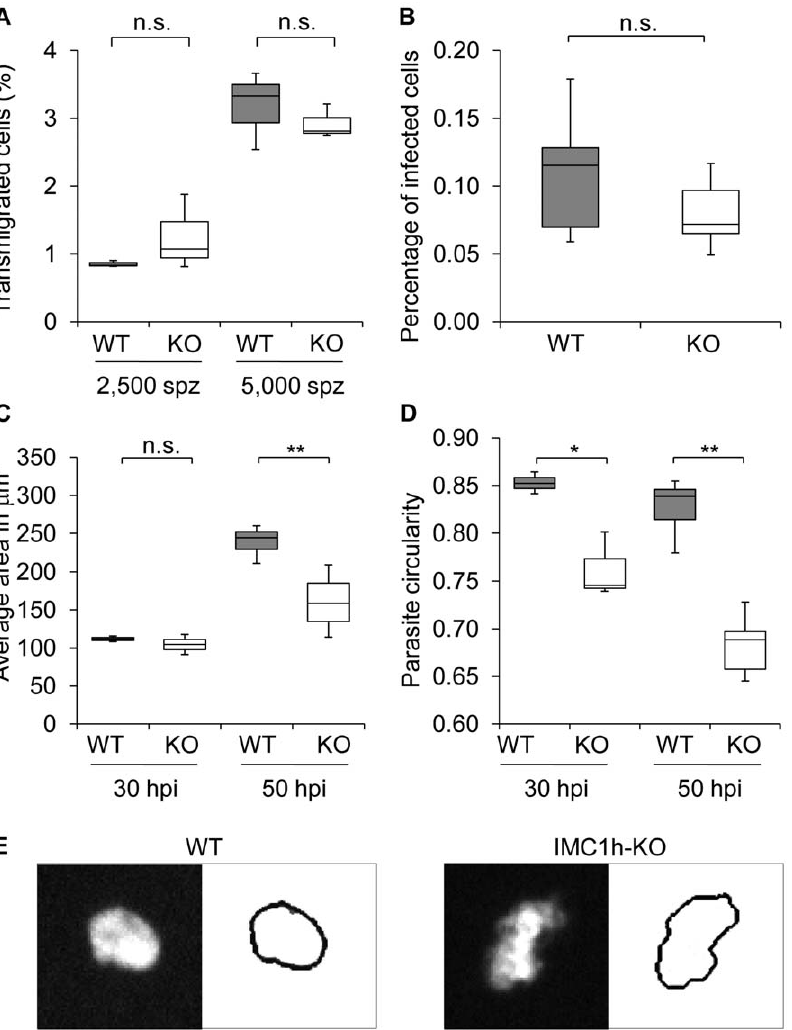
Figure 6. Invitro transmigration ability, infectivity and intracellular development of IMC1h-KO parasites. A. Hepa 1–6 cells were incubated with WT or IMC1h-KO sporozoites (spz) in the presence of rhodamine-dextran for two hours. The results are given as the percentage of cells filled with rhodamine-dextran (WT 2,500 spz, n=3, 257 cells; IMC1h-KO 2,500 spz, n=3, 234 cells; WT 5,000 spz, n=3, 561 cells; IMC1h-KO 5,000 spz, n=3, 403 cells). B. Hepa 1–6 cells invasion rate of WT and IMC1h-KO parasites at 50 hpi. Results are given as percentage of infected cells (WT, n=6, 341 cells; IMC1h-KO, n=6, 186 cells). C. Parasite area of WT and IMC1h-KO parasites in Hepa 1–6 cells at 30 and 50 hpi (WT 30 hpi n=3, 181 cells; IMC1h-KO 30 hpi, n=3, 99 cells; WT 50 hpi, n=6, 341 cells; IMC1h-KO 50 hpi, n=6, 186 cells). D. Average circularity of WT and IMC1h-KO parasites in Hepa 1–6 cells at 50 hpi. Mutant parasites displayed a lower circularity than WT parasites indicating a more irregular and elongated shape (WT 30 hpi n=3, 181 cells; IMC1h-KO 30 hpi, n=3, 99 cells; WT 50 hpi, n=6, 341 cells; IMC1h-KO 50 hpi, n=6, 186 cells). E. Cropped images acquired with Cellomics ArrayScan VTI HCS Reader show WT (left panel) and IMC1h-KO (right panel) GFP stained parasites. The parasite outline calculated by the SpotDetector BioApplication algorithm is depicted to the right of each image.